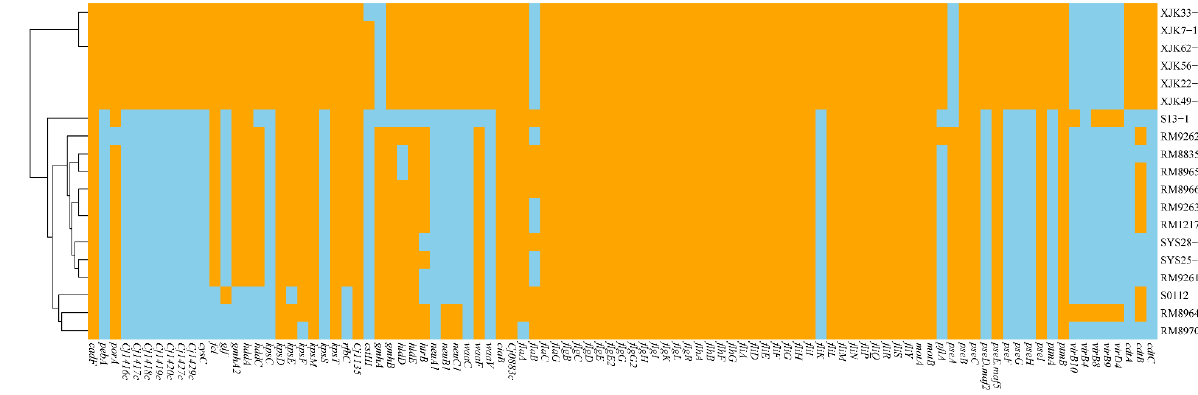
Figure 4. Heatmap of the distribution of virulence genes. Orange indicates the presence of the vir ‐ ulence genes, and sky blue indicates the absence of the virulence genes. virulence genes, and sky blue indicates the absence of the virulence